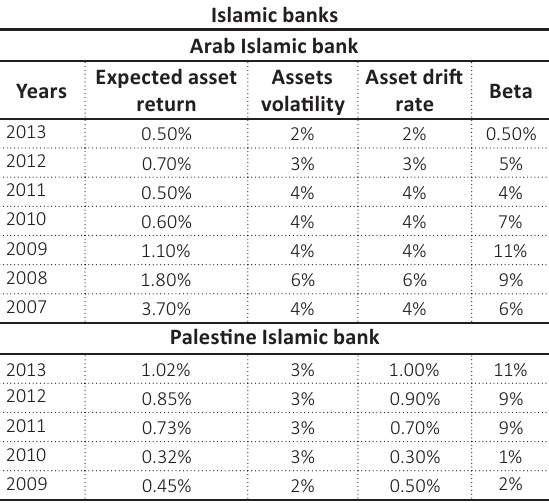
Table 2. Expected asset returns of Islamic